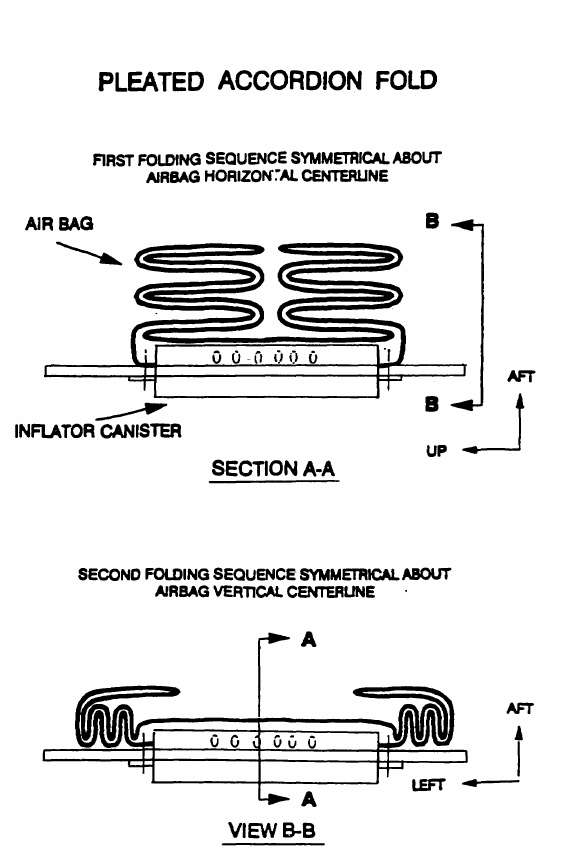
FIGURE 2 Sectional view of an pleated accordion folded